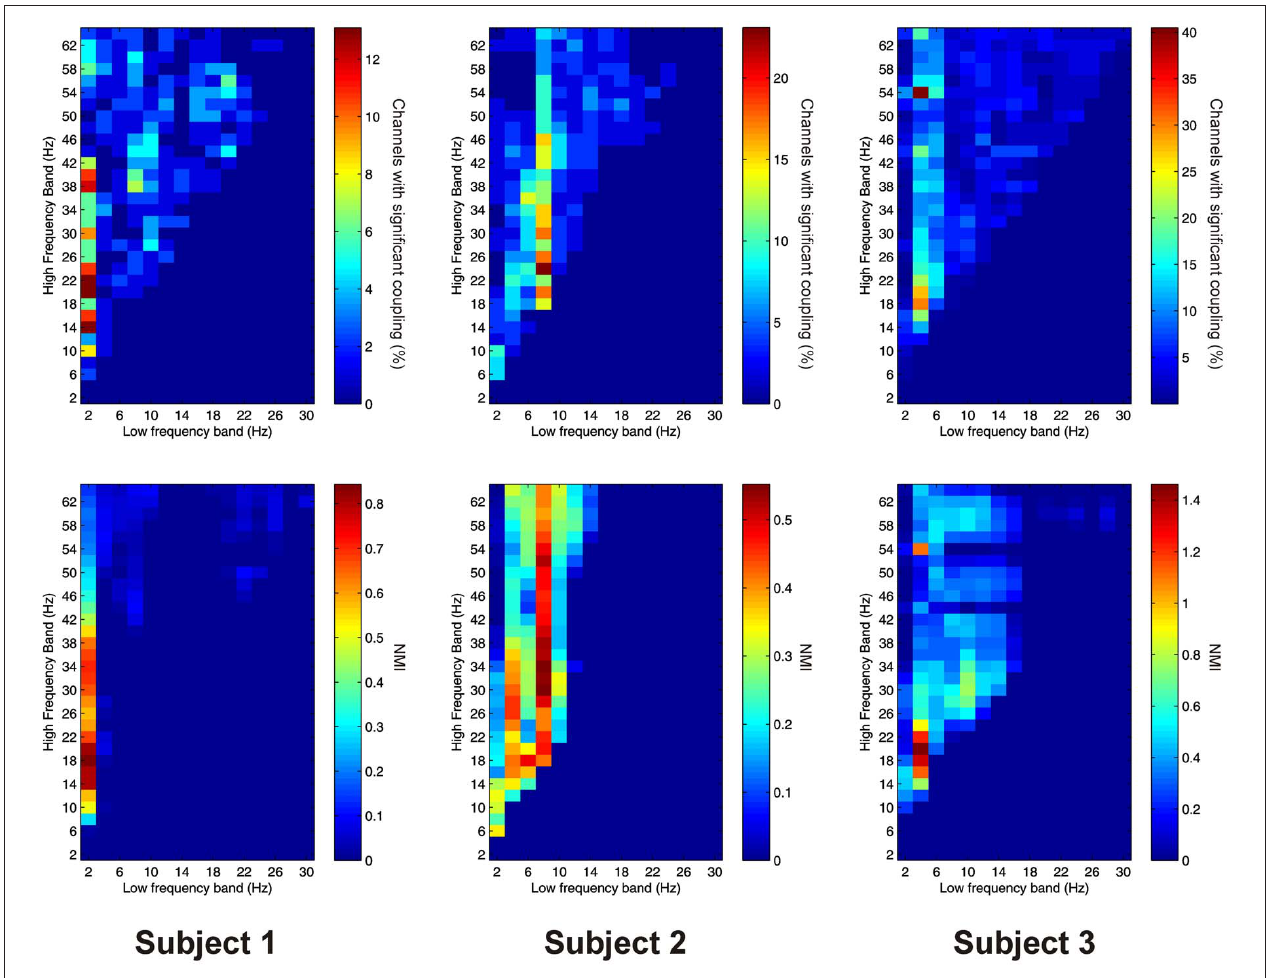
FIGURE 6 | Top row: Proportion of channels showing significant thalamo-cortical PAC (coupling between a low-frequency in the thalamus and a high-frequency in the cortex) (Subject 1 left, Subject 2 middle, Subject 3